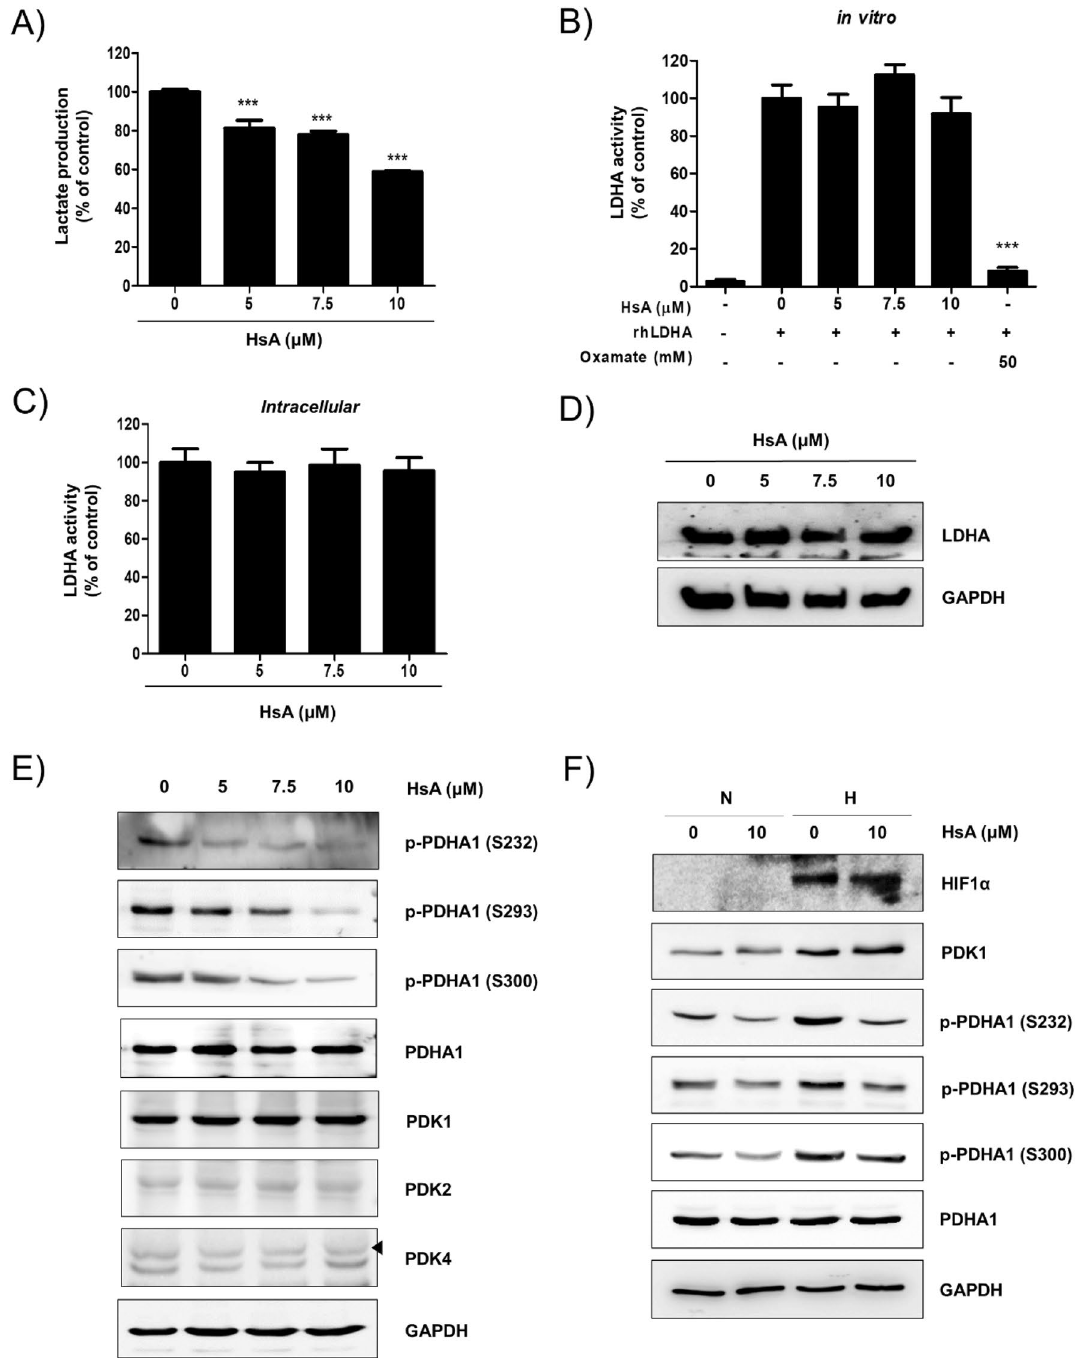
Figure 2. HsA suppresses the lactate production by inhibiting the PDK1 activity. ( A ) DLD-1 cells were treated with the indicated concentrations of HsA (0, 5, 7.5, 10 μM) for 4 h. Production of lactate in DLD-1 cell culture media was determined using a commercially available lactate assay kit. ( B ) In vitro LDHA activity was estimated using recombinant human LDHA with the indicated concentration of HsA (0, 5, 7.5, 10 μM) or Oxamate (50 mM). ( C ) DLD-1 cells were incubated with the indicated concentrations of HsA (0, 5, 7.5, 10 μM) for 4 h. The cells were lysed and LDHA activities were measured using the cell lysates as an enzyme source. ( D ) DLD-1 cells were cultured with the indicated concentrations of HsA (0, 5, 7.5, 10 μM) for 4 h. The levels of LDHA were examined by Western blot analysis. GAPDH expression was used as an internal loading control. ( E ) DLD-1 cells were cultured with the indicated concentrations of HsA (0, 5, 7.5, 10 μM) for 4 h. The levels of phosphorylated PDHA1 (S232, S293 and S300), total PDHA1, PDK1, PDK2, and PDK4 were examined by Western blot analysis. GAPDH expression was used as an internal loading control. The results ( A , B ) are shown as mean + SEM. ***p < 0.001 compared with the control group. ( F ) DLD-1 cells were treated with HsA (0, 10 μM) under normoxic or hypoxic conditions for 4 h. The levels of HIF1α, the phosphorylated PDHA1 (S232, S293, and S300), total PDHA1, and PDK1 were examined by Western blot analysis. GAPDH expression was used as an internal loading